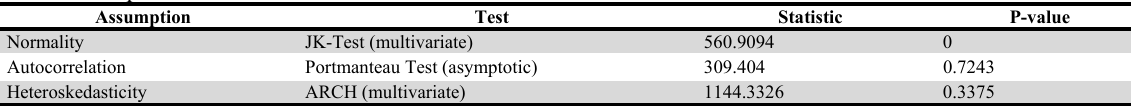
Table 8 analyzes the assumptions on the errors of the econometric model: normality, serial correlation and heteroscedasticity. It can be seen that all the assumptions except for the normality of the errors, are exceeded. Model Assumption